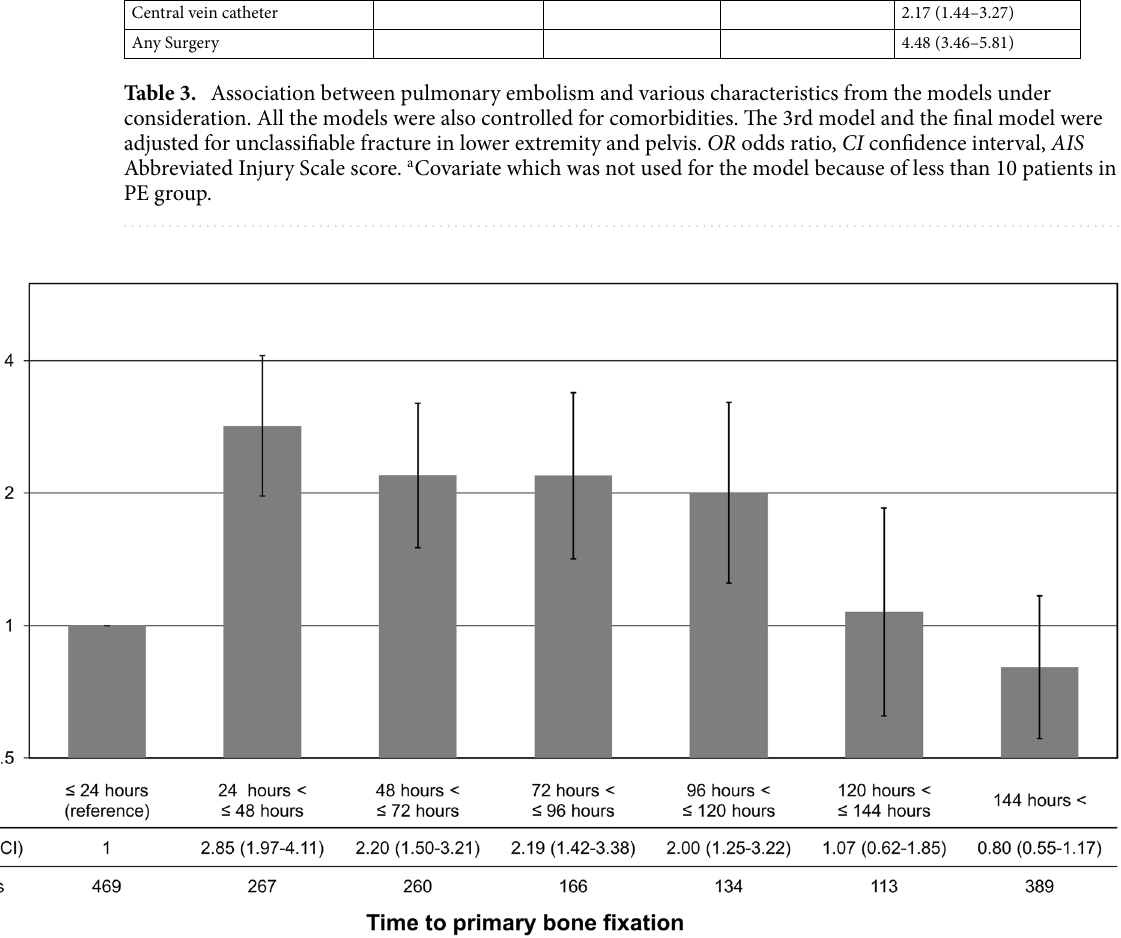
Figure 2. Association between pulmonary embolism and time to primary bone fixation. This figure is the result of subgroup analysis using non-conditional logistic regression model. This model was adjusted for the same covariates as in the final model. Definition of abbreviations: OR = odds ratio; CI = confidence